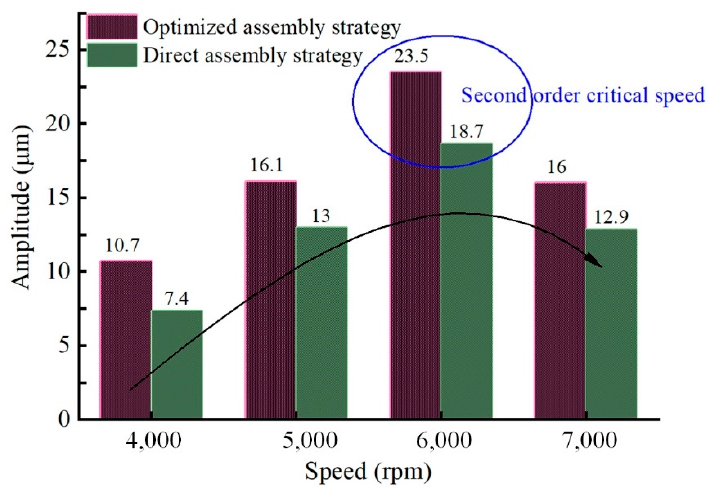
Figure 8. Vibration amplitude of rotary parts rotor under different assembly strategies.